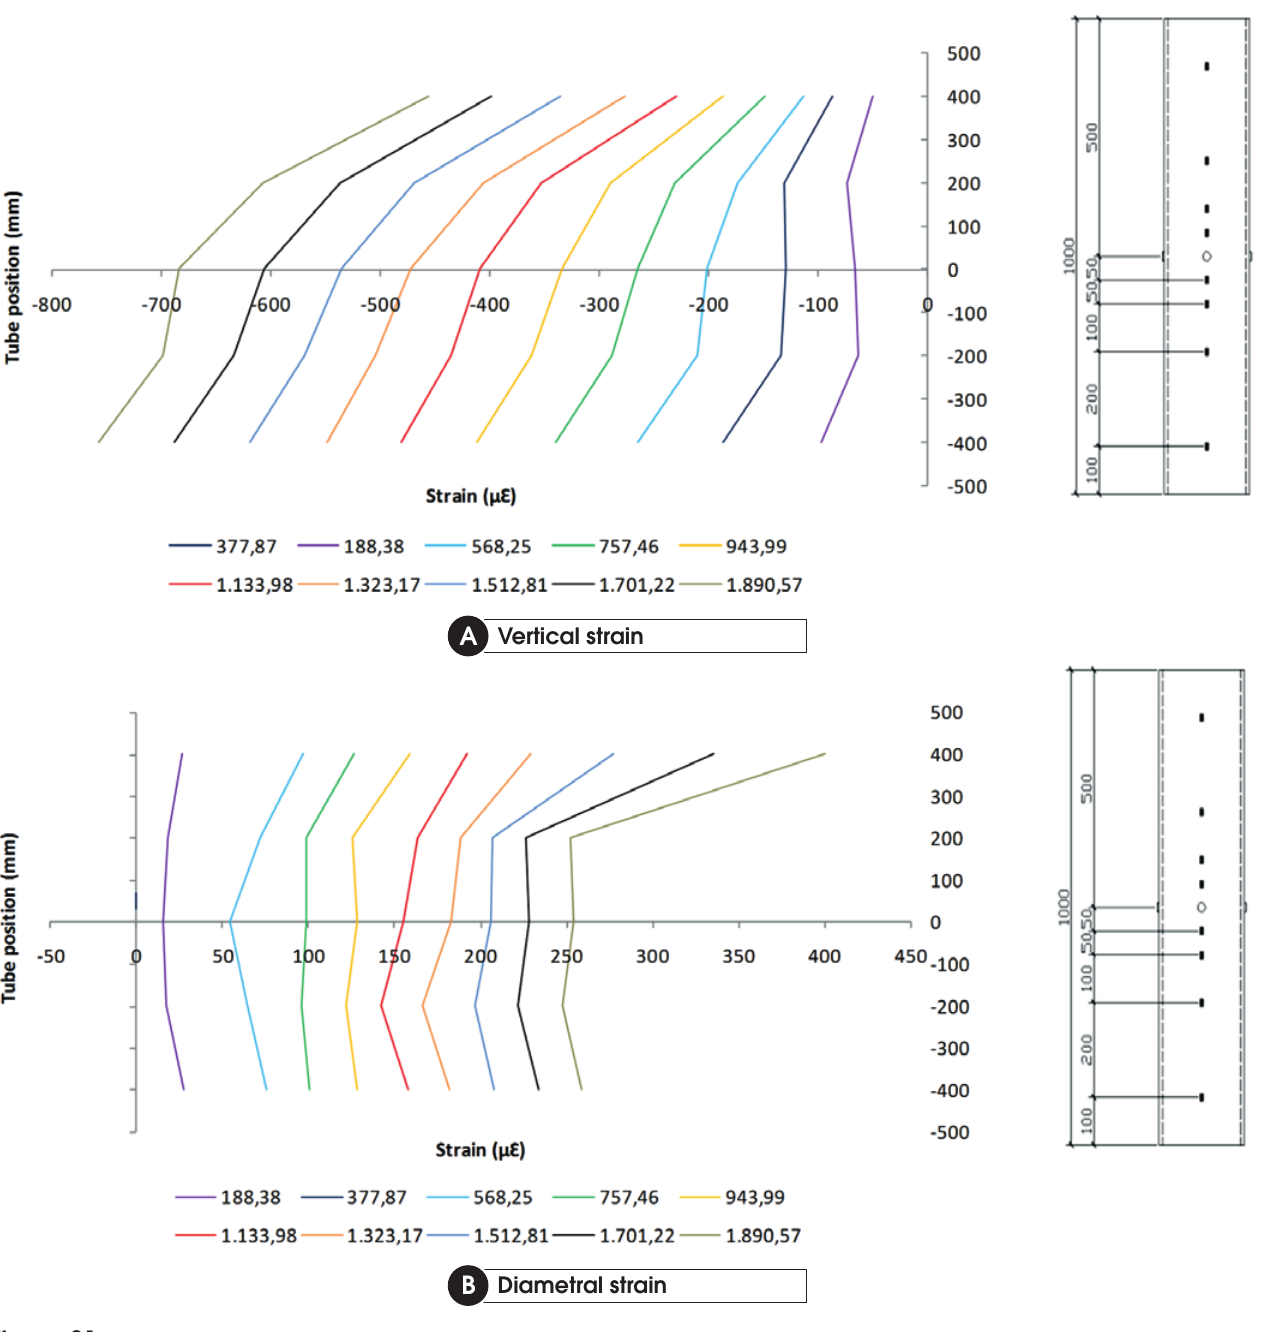
Figure 21 Distribution curves of the strains along the tube - C16-15,1-SC-25,2